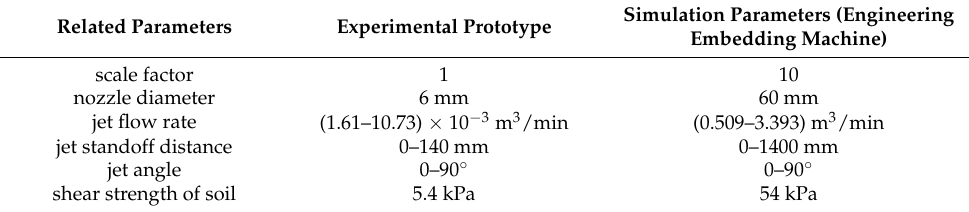
Table 2. Experimental parameters and numerical simulation